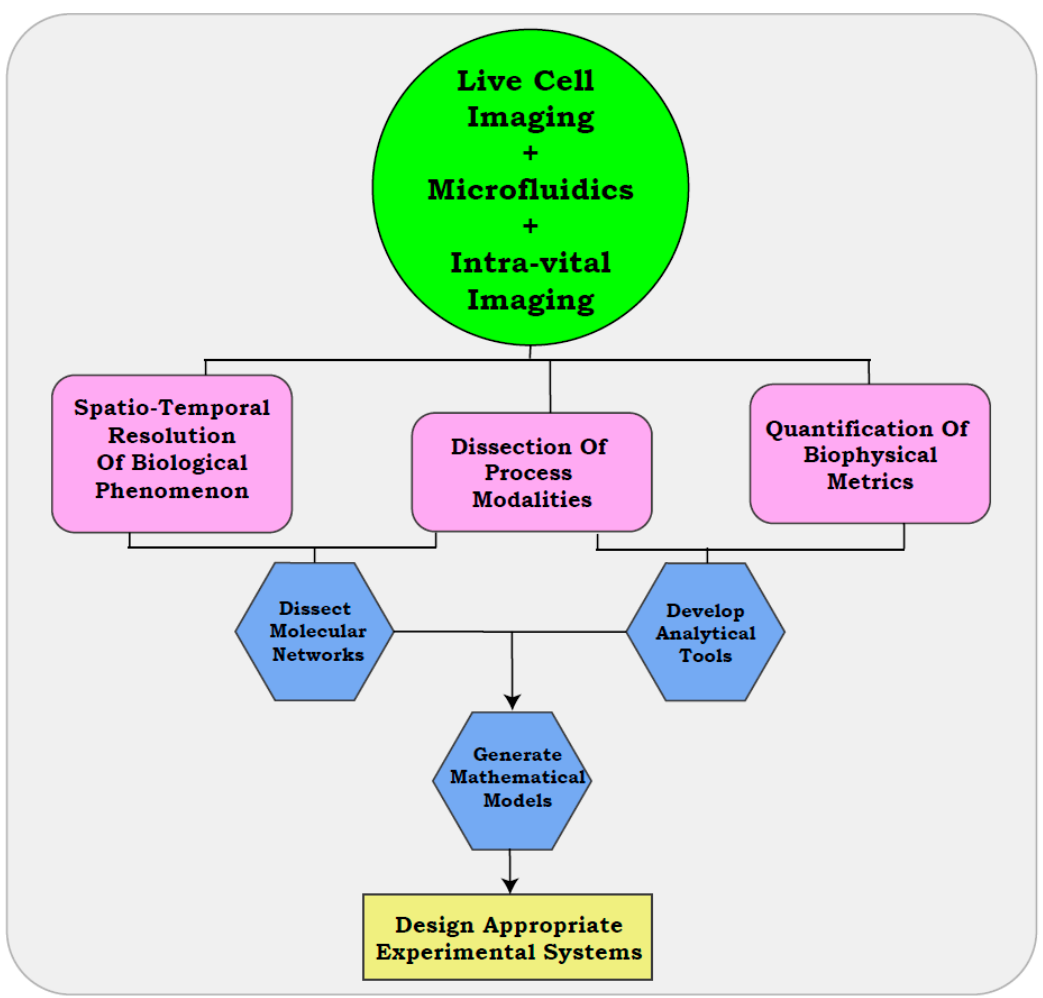
Figure 3. Era of real-time analysis. Routine implementation of real-time approaches in cancer